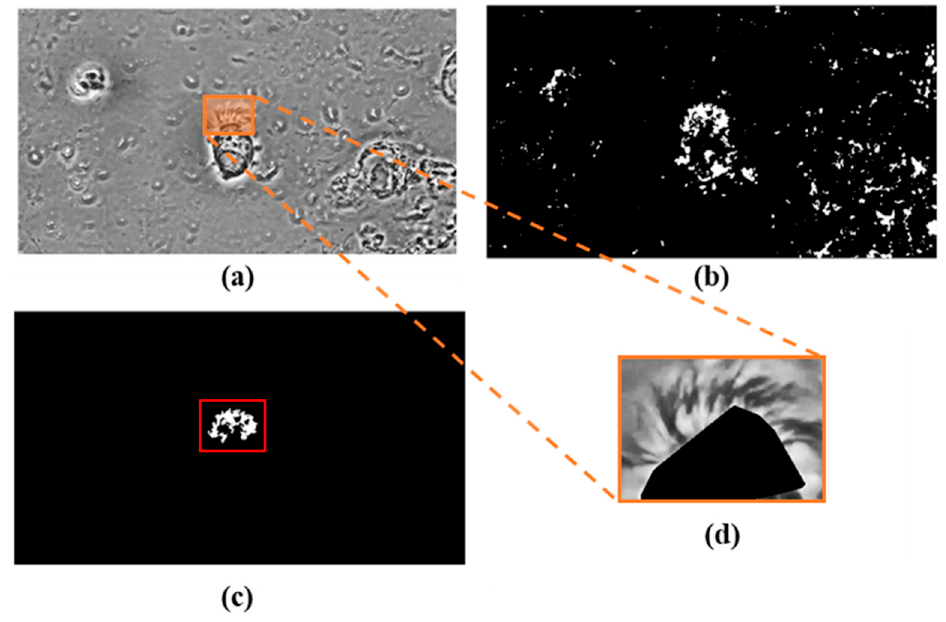
Figure 6. Steps of BeatCilia from the “cilia 1” video: ( a ) an equalized frame; ( b ) result of the dense